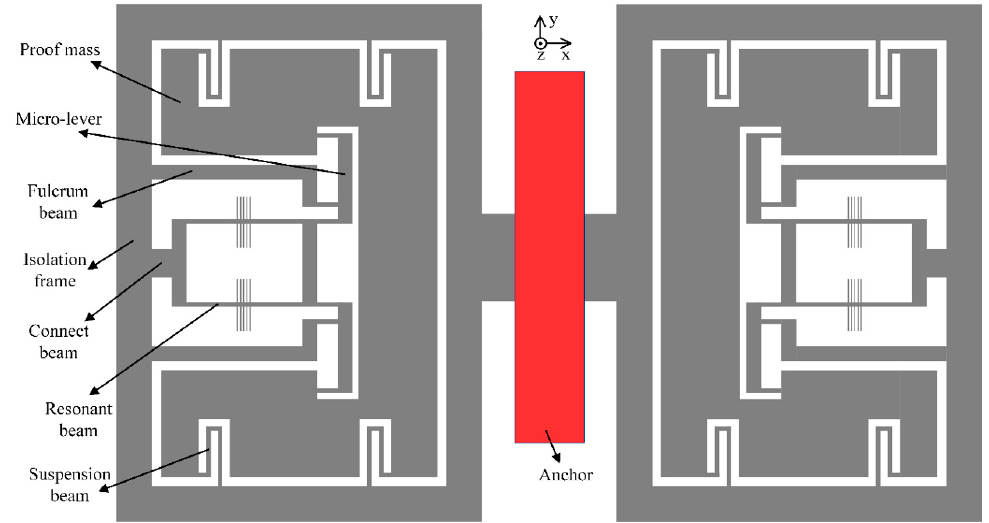
Figure 6. The schematic structure with single-anchored isolation frame.